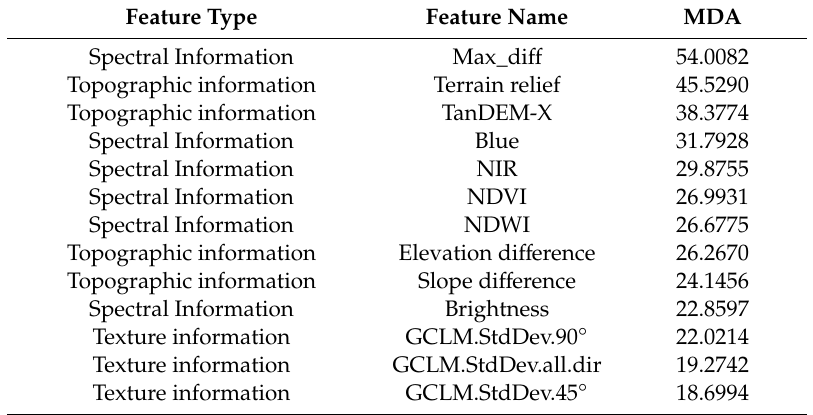
Table 2. Top 13 features ranked by Random Forest Cross-Validation and Variable Importance in